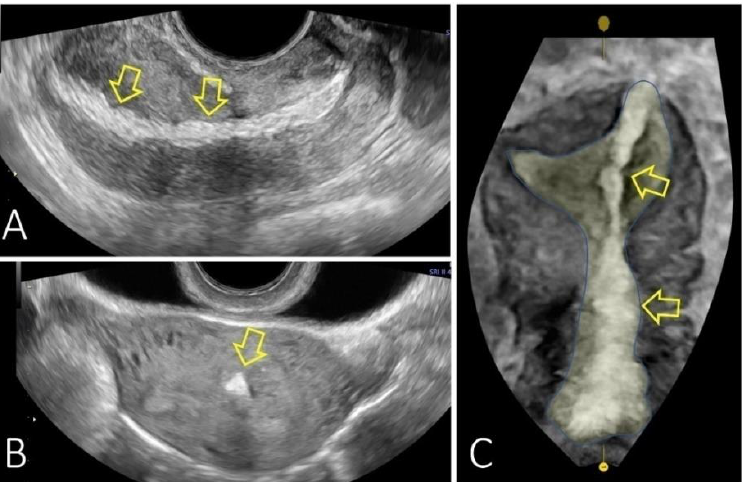
Figure 2. Ultrasound evaluation at 6 h after the curettage. ( A ): Longitudinal view of the uterus with the identification of an echogenic band in the uterine wall and cavity extending from the uterine fundus to the cervical external os (yellow arrows); ( B ): Transversal plane of the uterine body for the width evaluation of the echogenic area; ( C ): 3D reconstruction of the uterine coronal plane showing the endometrial and cervical cavity and the localization of the echogenic area. (Case from the Department of Obstetrics and Gynecology, University of Medicine and Pharmacy of Craiova, Romania).